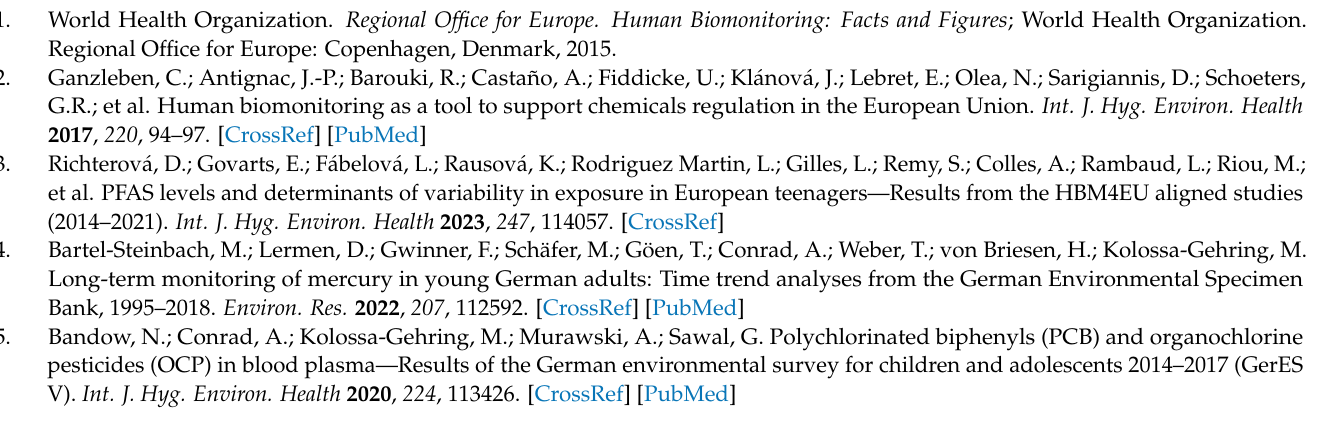
Table S1: Variables considered for extended sex/gender analysis; Table S2: Results of the logistic regres- sion analysis for the urinary TBBA and lysmerol concentration of GerES V